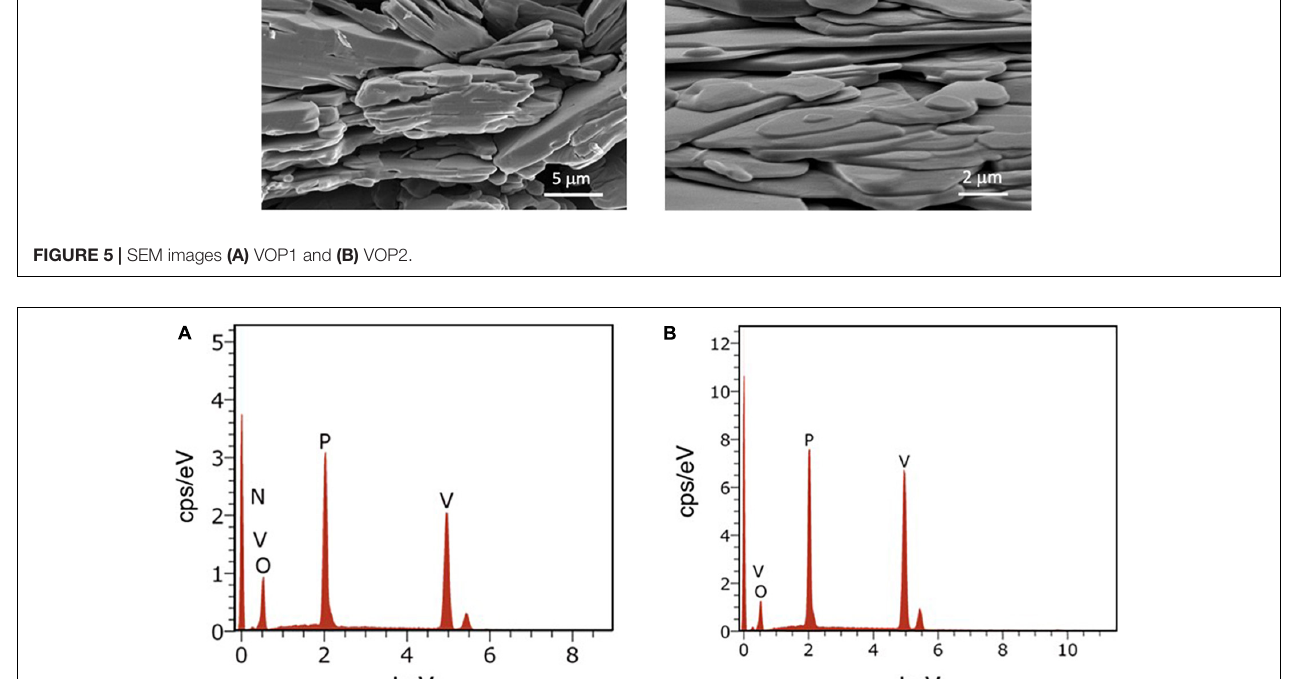
FIGURE 6 | EDS analysis of (A) VOP1 and (B)